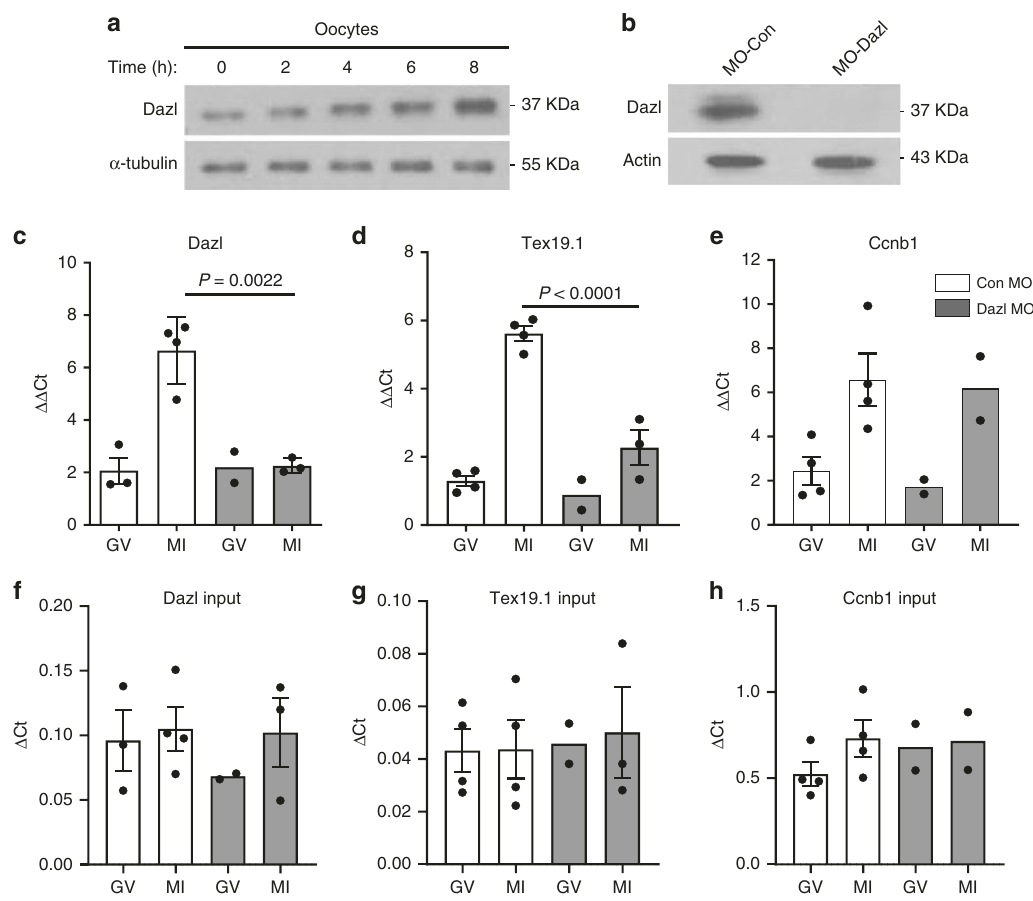
Fig. 1 Interference with Dazl mRNA translation depletes oocytes of the DAZL protein and inhibits translation of a speci fi c downstream target. a DAZL protein accumulation during the transition from the GV-to-MI stages of oocyte maturation. GV stage oocytes from wild type mice were cultured in vitro up to 8 h of maturation and used for Western blot analysis. 150 oocytes per lane was loaded on the gel and accumulation of α -tubulin was used as a loading control. The complete time course was performed once, while changes between the fi rst and last time point con fi rmed in two additional independent experiments (see Supplementary Fig 1a). b Morpholino oligonucleotide (MO) down-regulation of DAZL protein. GV stage oocytes from RiboTag fl / fl :Zp3- Cre:WT or RiboTag fl / fl :Zp3-Cre:DAZL + / − mice were injected with CON-MO or DAZL-MO as described in the methods. After 6 h, oocytes were collected and used for Western blot analysis. A representative experiment of the three performed is reported. c – e GV stage oocytes from RiboTag fl / fl :Zp3-Cre or RiboTag fl / fl :Zp3-Cre:Dazl + / − mice were injected with CON-MO or DAZL-MO and preincubated overnight in 2 µ M milrinone, then cultured in inhibitor-free medium for maturation. Oocytes were collected at 0 and 6 h for RiboTag IP followed by qPCR analysis. Ribosome loading of the endogenous Dazl mRNA (unpaired two tailed t -test, p = 0.0022) and Tex19.1 (unpaired two tailed t -test, p < 0.0001), but not CcnB1 (unpaired two tailed t -test, P = 0.8567)